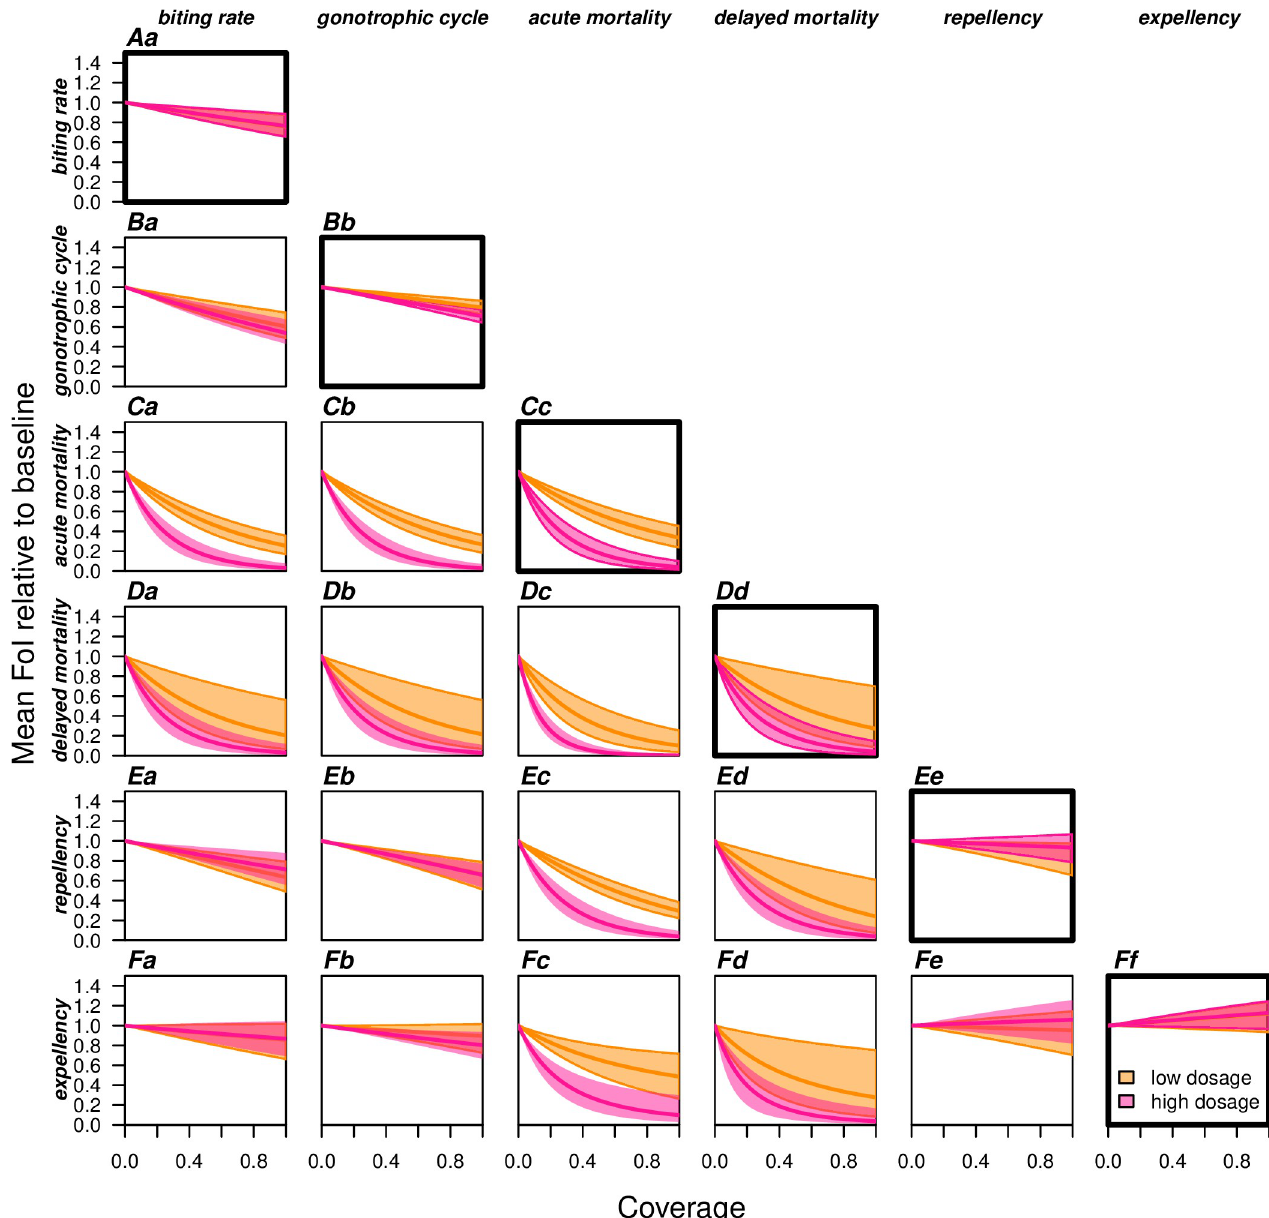
Fig 4. Composite effects of an experimental SR product containing transfluthrin on relative force of infection (FoI). Effects were assessed as a function of population coverage for different modes of action (A.-F.) (Table 2). The diagonal (bold, Aa-Ff) shows each product effect by itself. Off-diagonal planes show each product effect combined with one other product effect (.a-.f). The mean default estimates (solid lines) and the 2.5th and 97.5th percentile are shown for the low (orange) and the high (pink) experimental dosage.